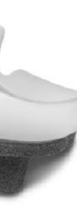
Figure 2. Two-peg monoblock TMT tibial component.